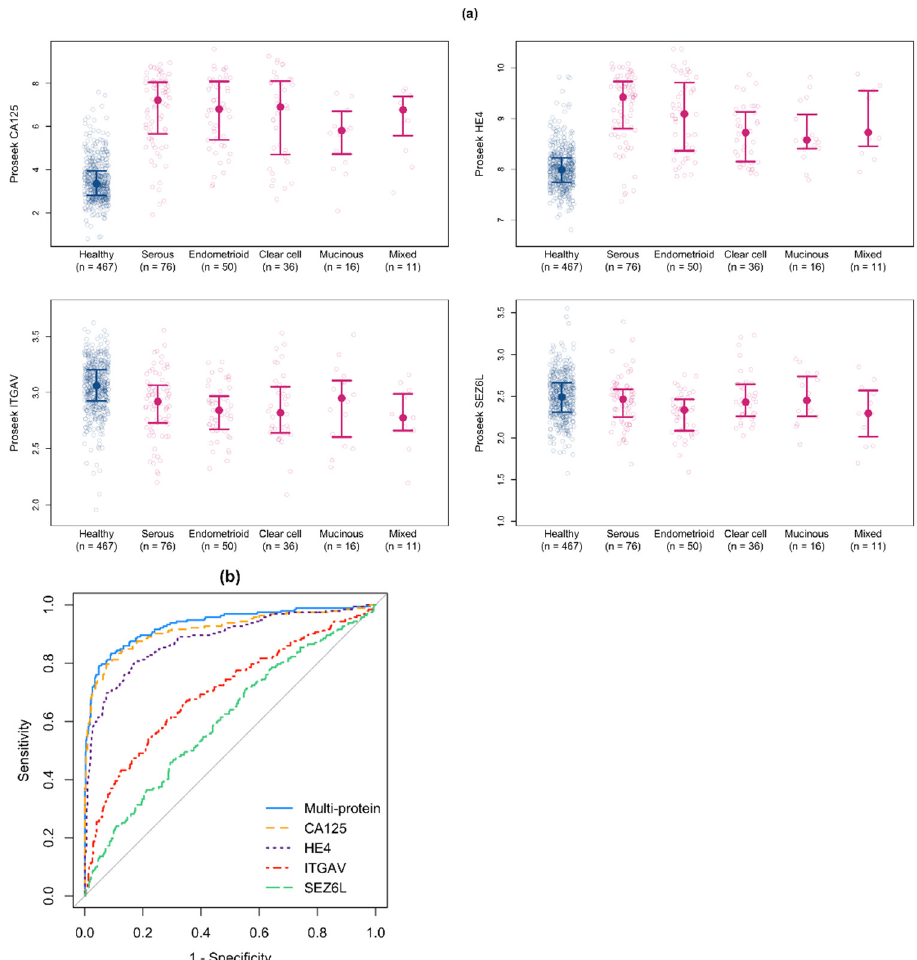
Figure 4. Validation of the multiprotein classifier for use with Cohort #2, a second cohort of early stage ovarian cancer samples. ( a ) Proseek NPX values of the proteins included in the early stage multiprotein classifier between healthy controls and early stage ovarian cancer samples from Cohort #2. The median and 25th/75th percentiles are shown in all plots. ( b ) ROC curves for the early stage multiprotein classifier applied to the Cohort #2 samples and individual proteins included in the early stage multiprotein